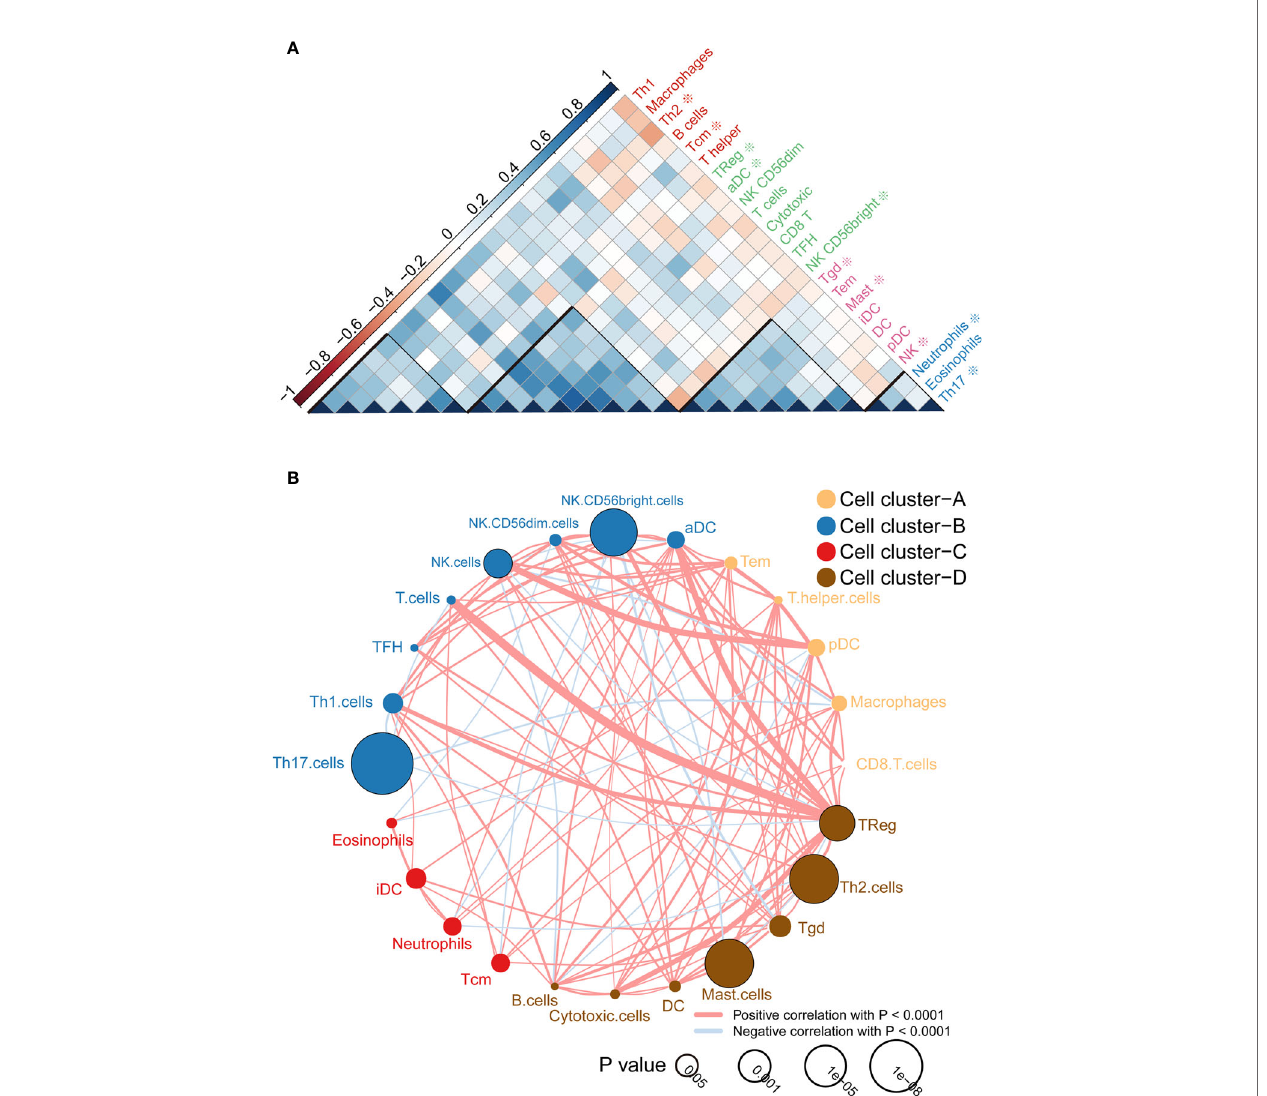
FIGURE 2 | Immune cell correlation analysis and interaction network. (A) Correlation analysis between cells, the scale is the correlation coef fi cient, and it can be divided into four categories, among which those related to the prognosis of survival analysis are marked with * ; (B) Cell-cell interaction network, which is divided into four categories according to the K-means clustering algorithm. Line thickness represents correlation, node size represents the P value for overall survival using the Kaplan-Meier